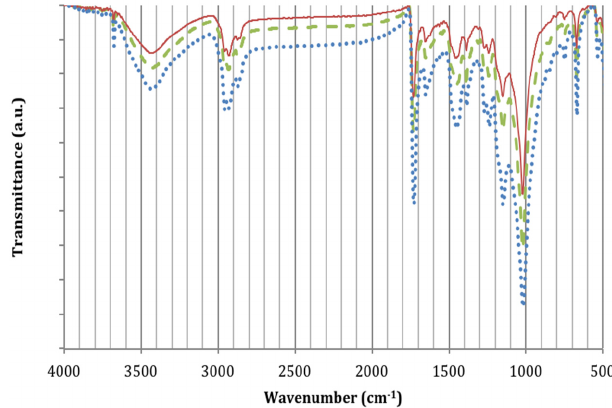
Figure 11. Infrared spectra (4000–400 cm − 1 ) of non ‐ metallic (black) graffiti on granite after accelerated ageing induced by Na 2 SO 4 salt cycles. The dotted blue line of the spectrum corresponds to the beginning of the treatment, the dashed grey line to the 7th cycle and the continuous orange line to the 14th cycle.